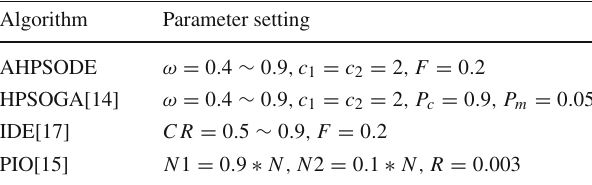
Table 11 Constraints for UAV control inputs and states